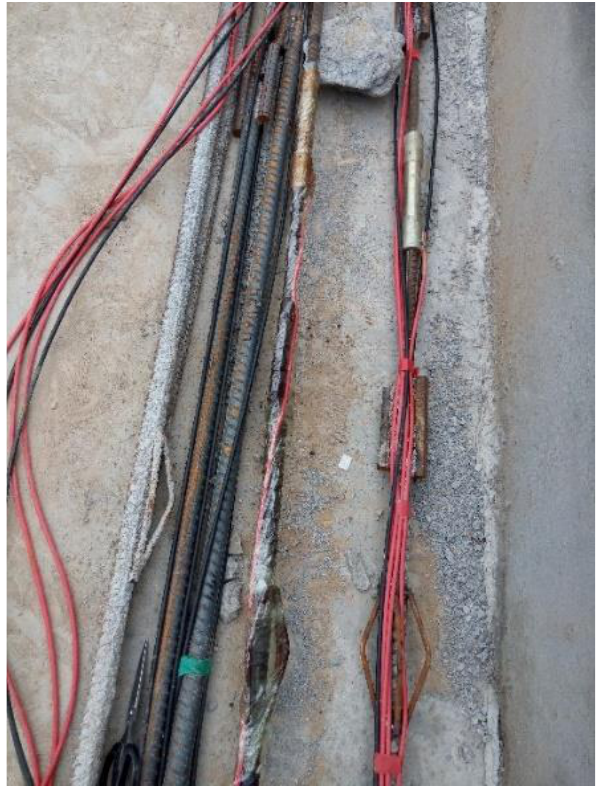
Figure 5. The manufactured testing anchors.